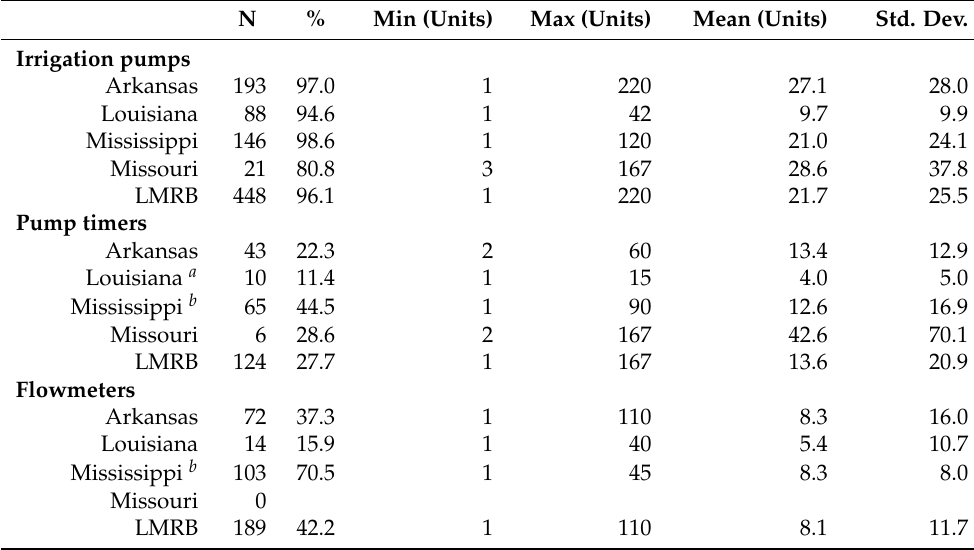
Table 8. Summary of irrigation groundwater pumping